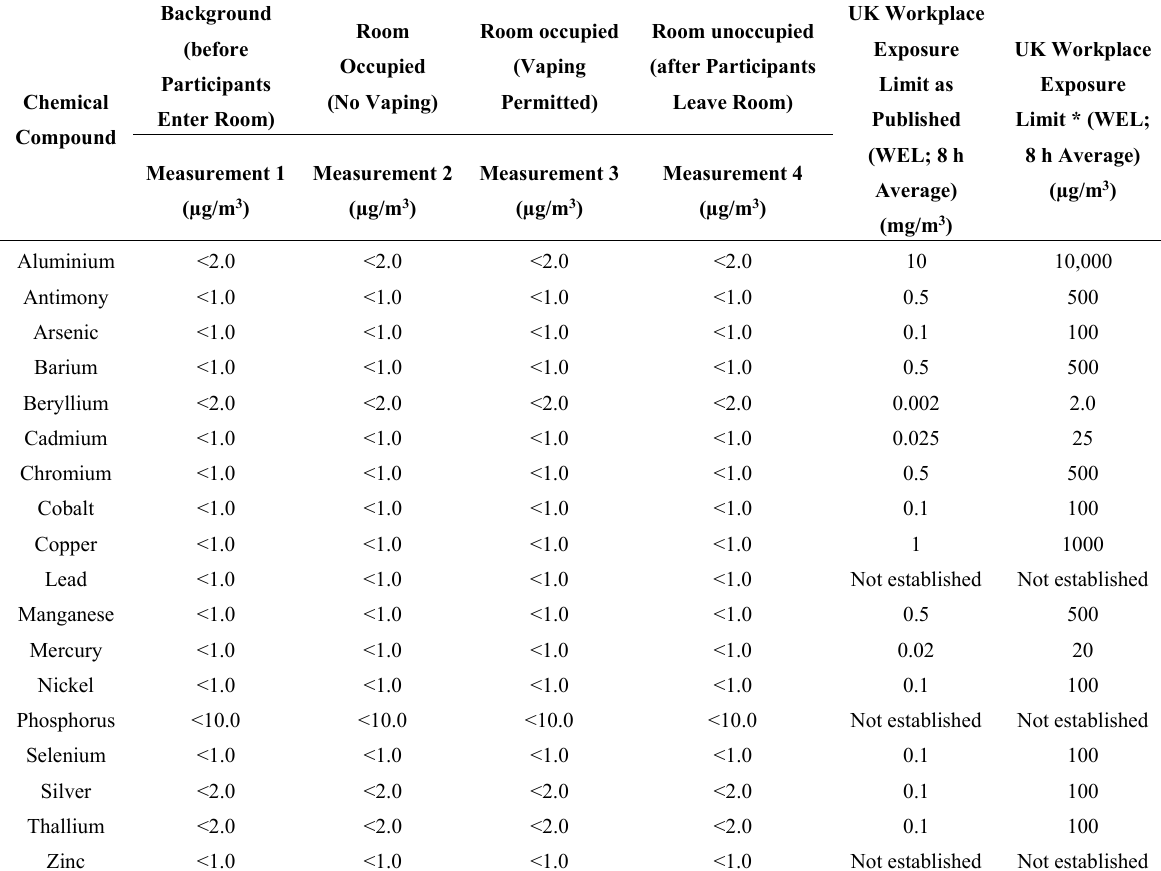
Table 3. Average indoor air concentrations of US “EPA Method 29” metals (plus aluminium and phosphorous) (µg/m 3 ) measured before, during and after use of e-cigarettes from two independent sampling